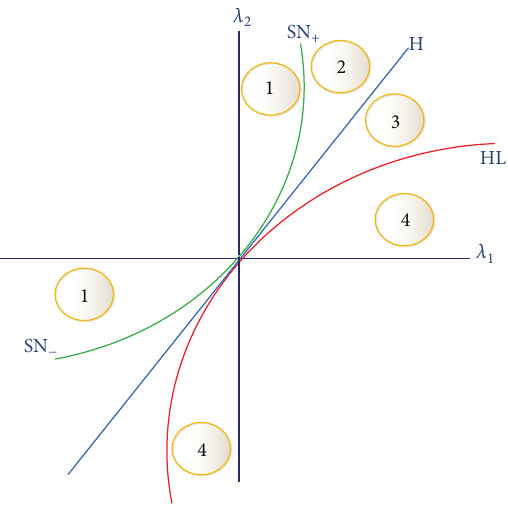
Figure 1: The bifurcation diagram of our